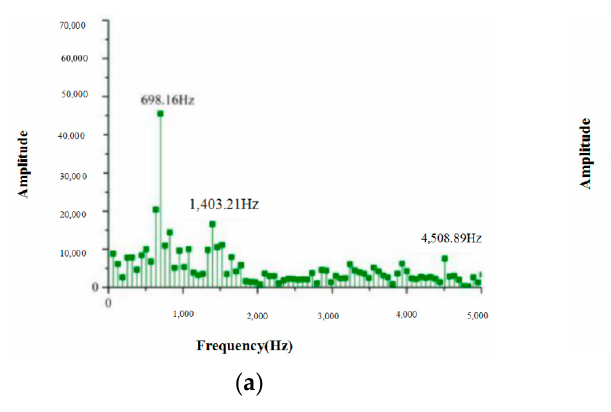
Figure 17. Relative velocity curve of the monitoring point when the flowrate is 0.6 kg/s: ( a ) the curve of the relative velocity at 8 points; ( b ) the curve of the relative velocity at 3 adjacent